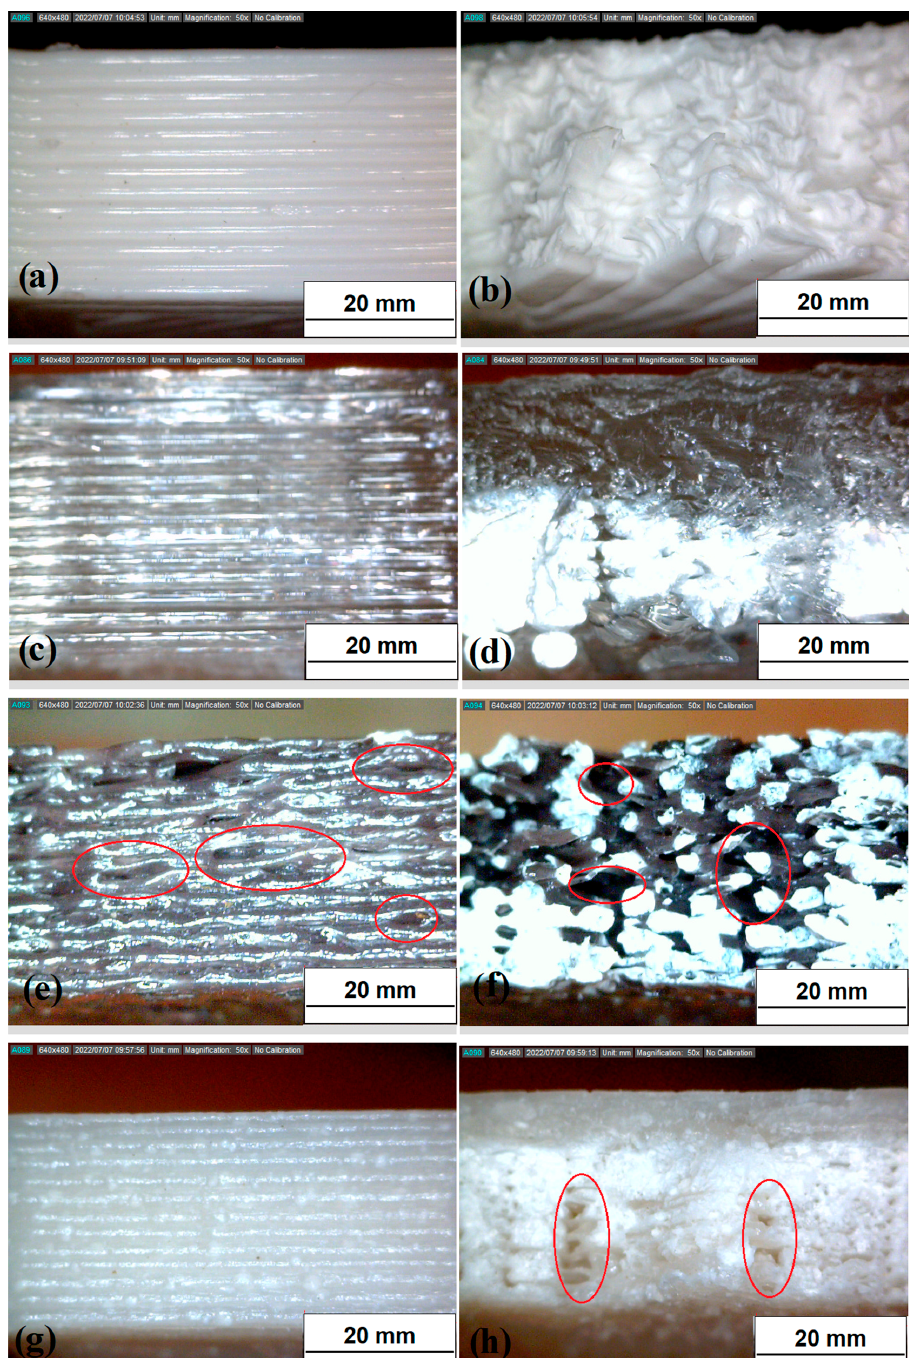
Figure 7. Magnified images (50×) of the 3D bars: ( a ) printing surface of D_3D specimen; ( b ) breaking surface after bending test of D_3D specimen; ( c ) printing surface of A_3D specimen; ( d ) breaking surface after bending test of A_3D specimen; ( e ) printing surface of B_3D specimen; ( f ) breaking surface after bending test of B_3D specimen; ( g ) printing surface of C_3D specimen; ( h ) breaking surface after bending test of C_3D specimen.